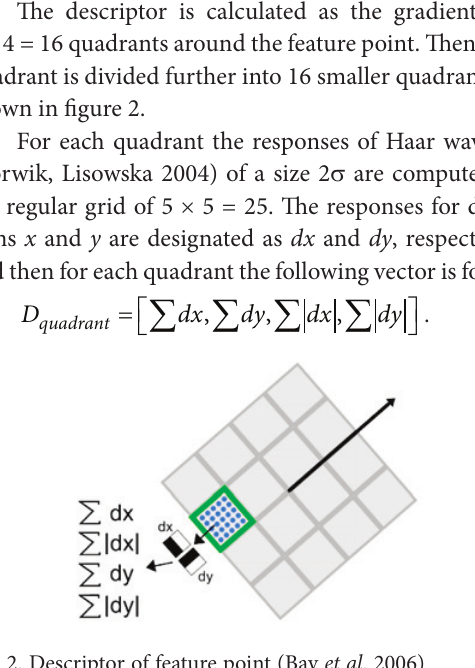
Fig. 2. Descriptor of feature point (Bay et al .